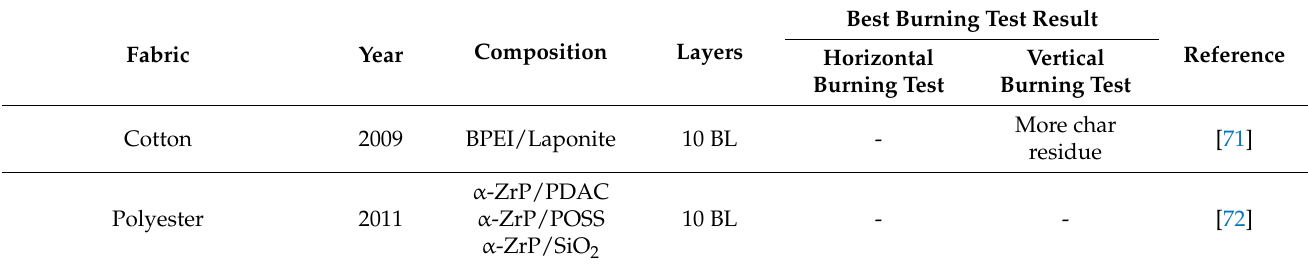
Table 4. Flame retardant effect of the LbL self-assembly coating on the fabric.